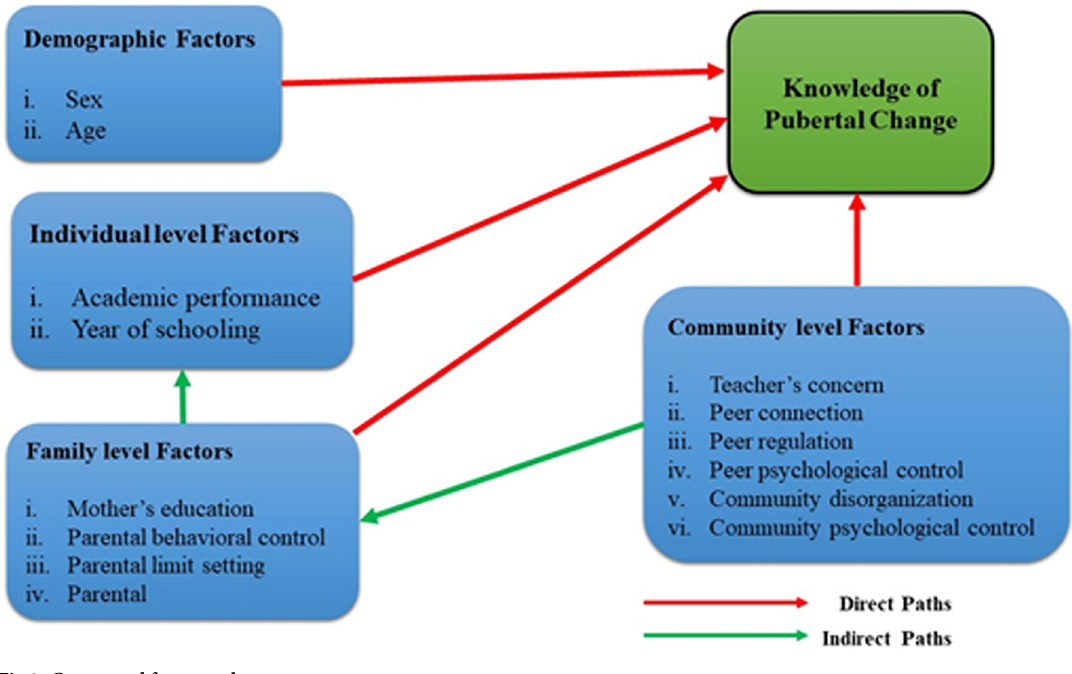
Fig 1. Conceptual